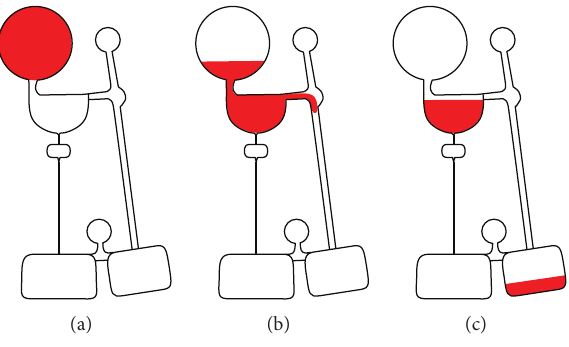
Figure 3: Design of overflow channel.